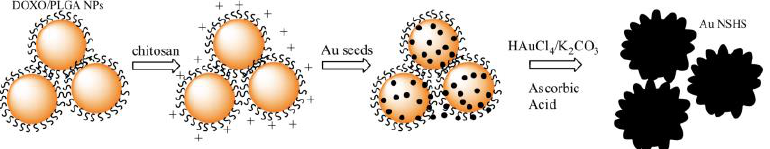
Figure 19. Schematics of synthesis of branched gold nanoshells. Reprinted with permission from Reference [123]. Copyright (2014) American Chemical Society.